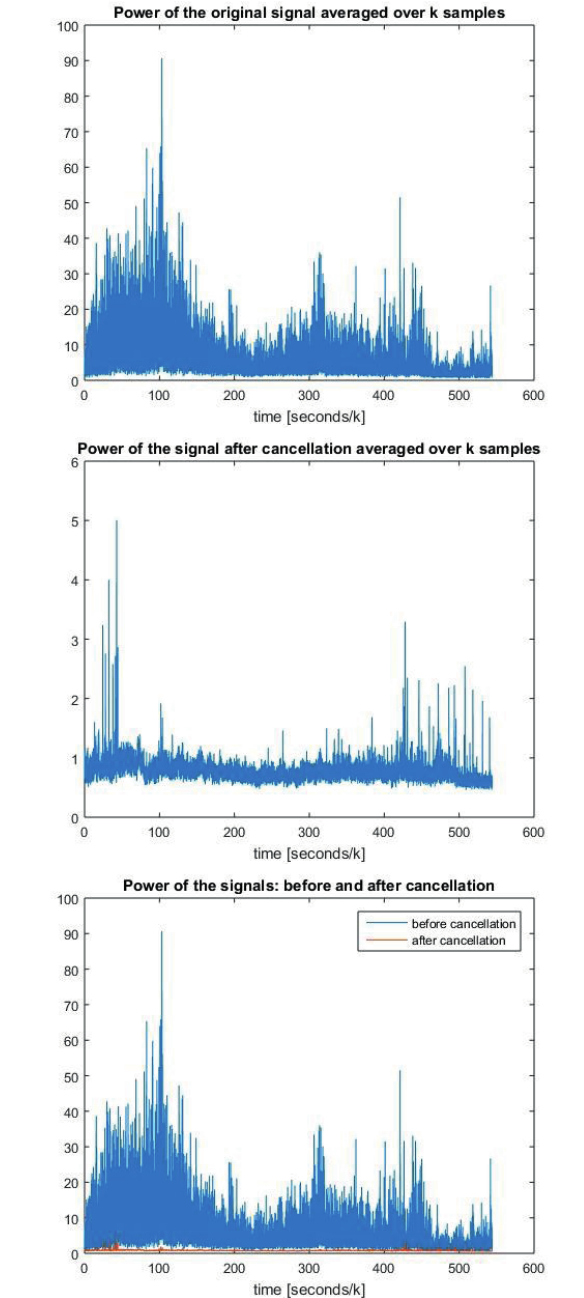
Fig. 6: Illustration of power before and after cancellation, for an example of infra-sound noise signal. Power calculated every 100 seconds.